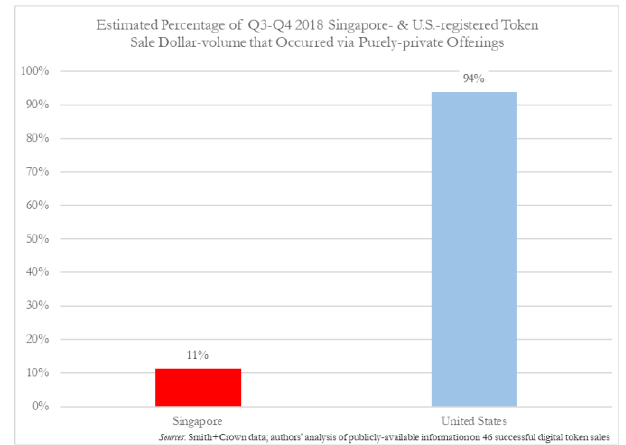
Figure 2. Purely-private token sales accounted for almost all Q3/Q4 2018 U.S. token sale volume, but were relatively minimal in